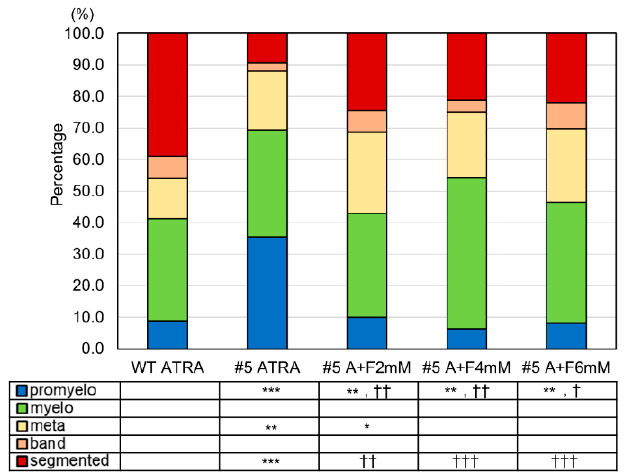
Figure 6. The effects of fructose on neutrophil differentiation in AK2-deficient HL-60 clones. Mor- phological classification in WT and clone #5 with or without fructose treatment. * p < 0.05; ** p < 0.01; *** p < 0.001 vs. WT ATRA. † p < 0.05; †† p < 0.01; ††† p < 0.001 vs. #5 ATRA.